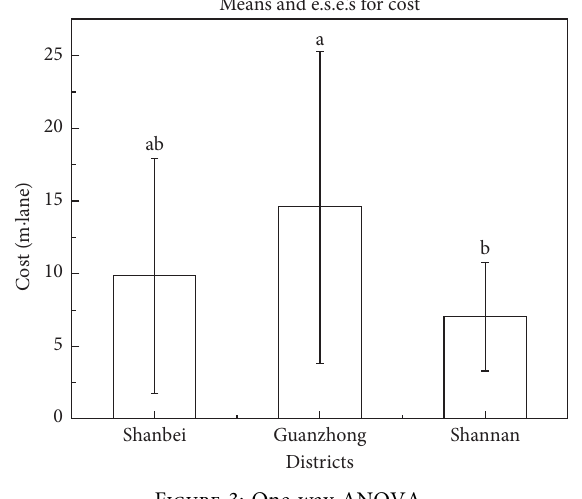
Figure 3: One-way ANOVA.